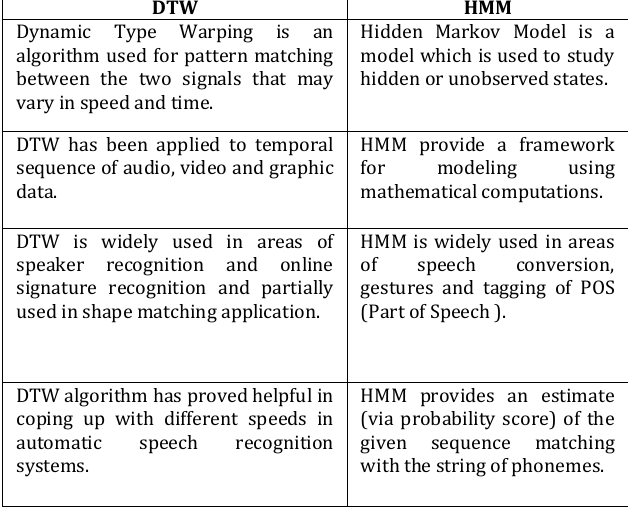
Table 1: Comparison of DTW and